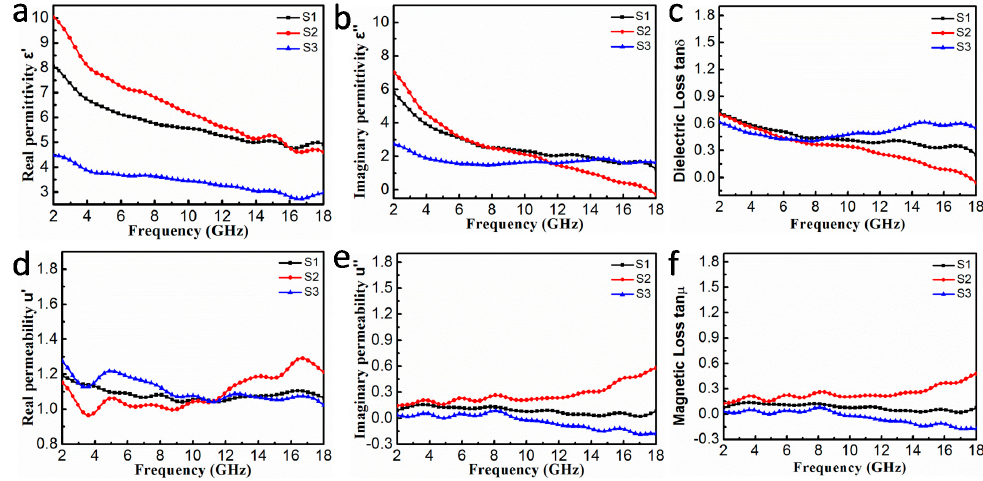
Figure 8. ( a ) Real and ( b ) imaginary parts of complex permittivity for S1, S2, and S3. ( d ) Real and ( e ) imaginary parts of complex permeability for S1, S2, and S3. ( c ) Dielectric loss tangents and (f ) magnetic loss tangents of S1, S2, and S3.